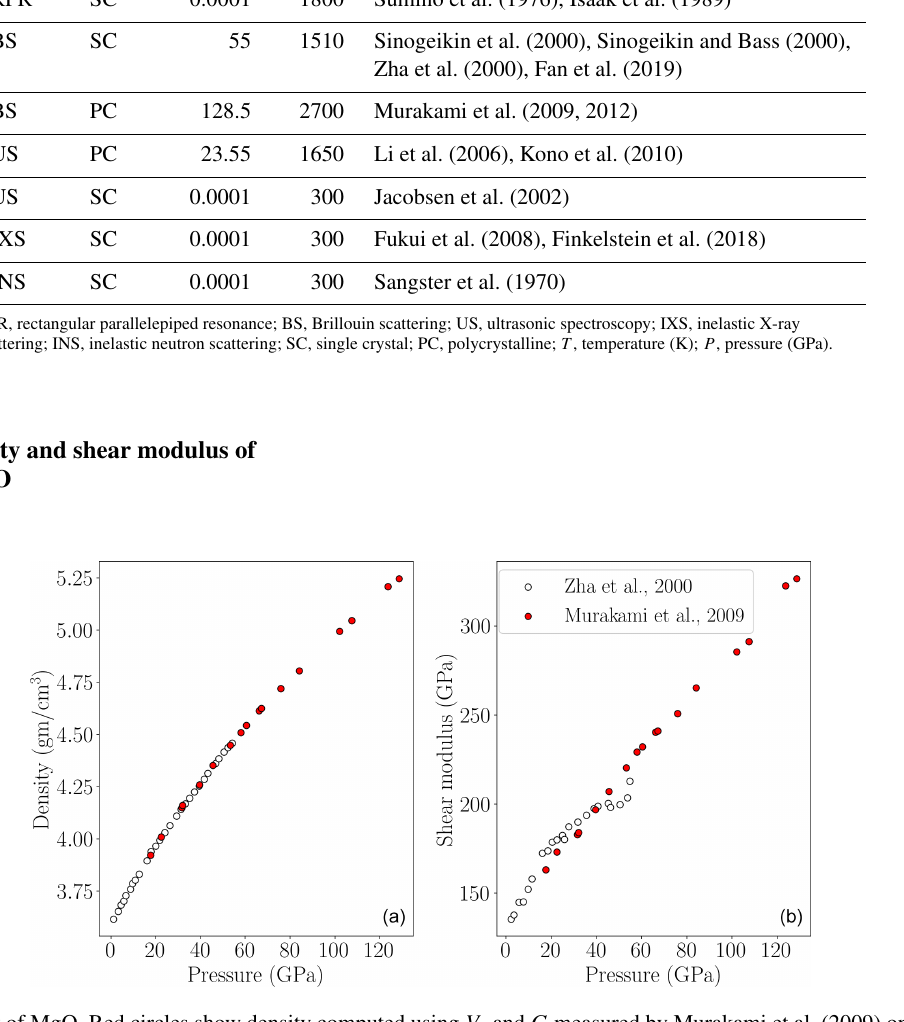
Figure B1. (a) Density of MgO. Red circles show density computed using V s and G measured by Murakami et al. (2009) on polycrystalline samples. White circles show density measured on a polycrystalline sample by Zha et al. (2000). (b) The shear moduli of MgO reported by Murakami et al. (2009) are from velocity measurements on polycrystalline samples, and those given by Zha et al. (2000) are based on single crystals. Whilst the densities between these two studies agree, the shear modulus values are